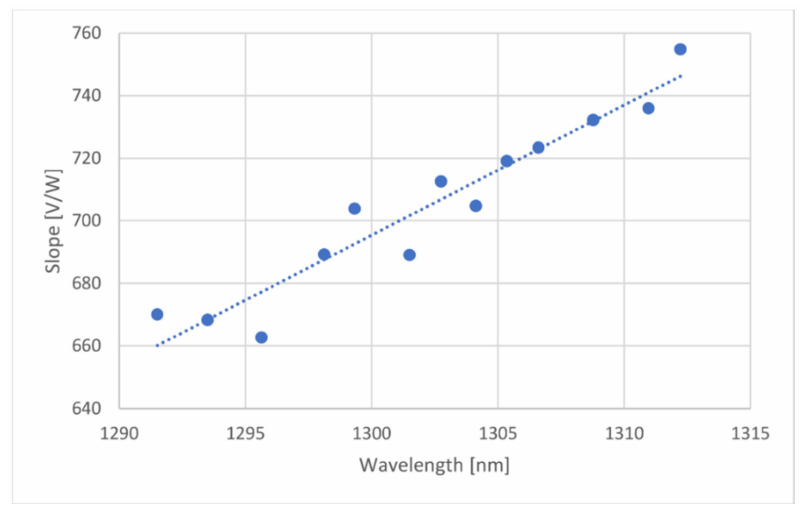
Figure 9. Input optical power over the output voltage slope as a function of the